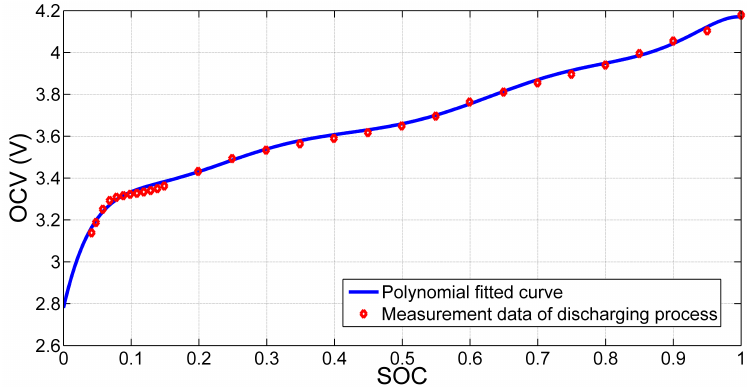
Figure 3. Identification results and mean value in [0.2, 1] of parameters R 0 , R 1 , R 2 , C 1 , C 2 .